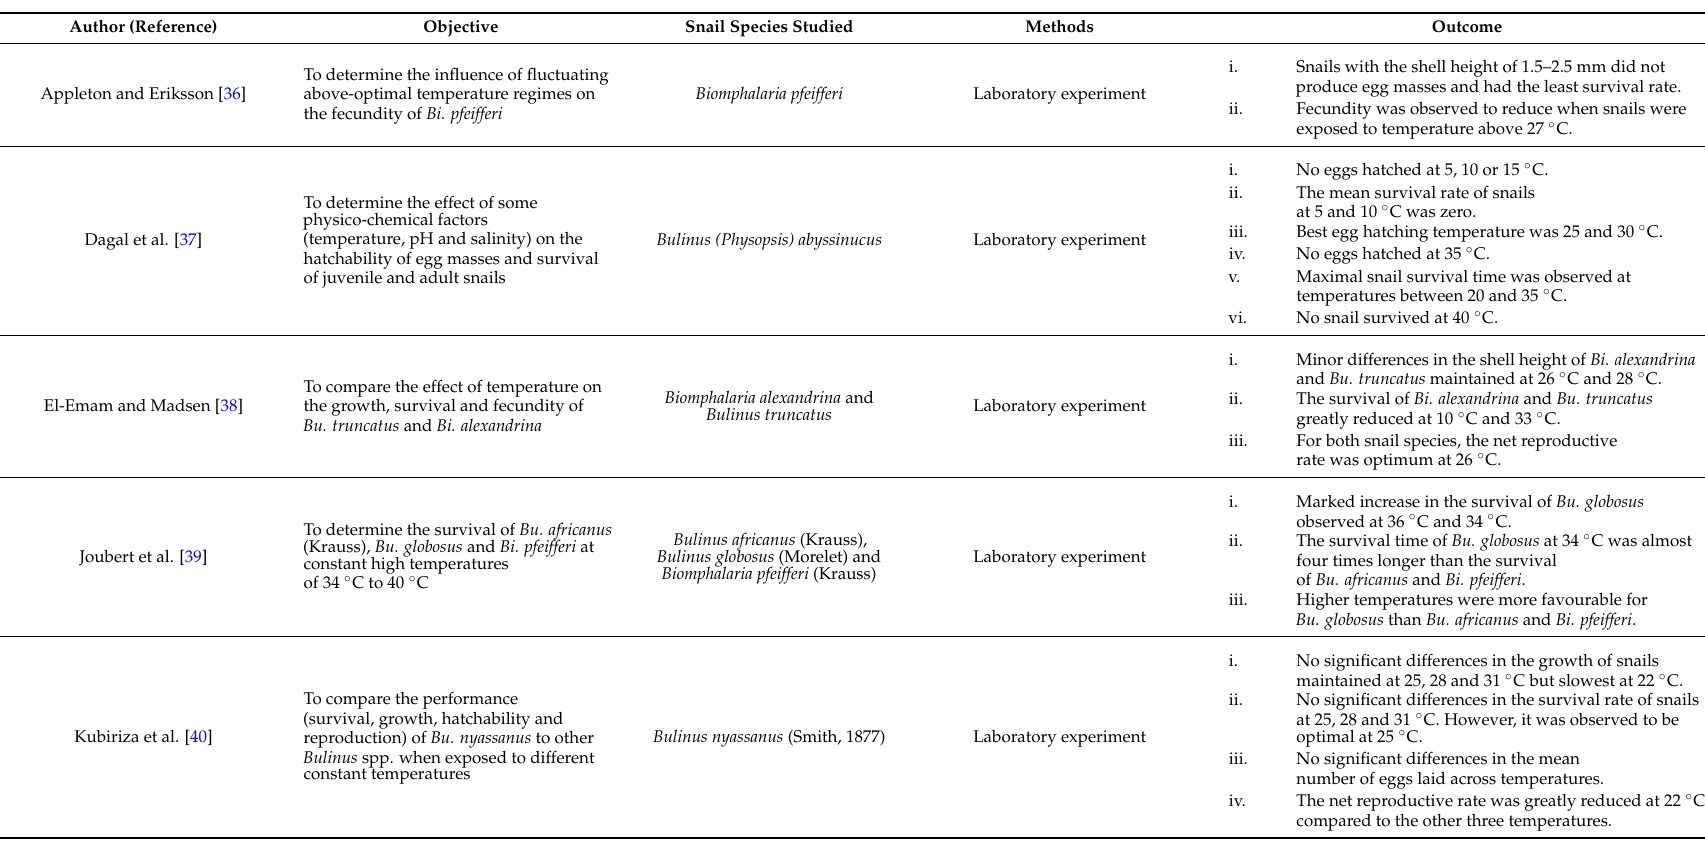
Table 1. Summary of laboratory studies, field studies and models that assessed the effect of temperature on Bulinus and Biomphalaria snail species between 1980 and